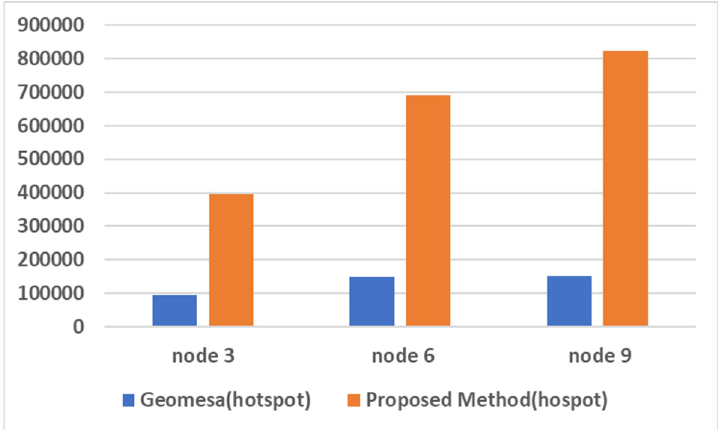
Figure 12. Ingestion throughput of Geomesa and the proposed method (Ingestion throughput: number of insertion operations per second).